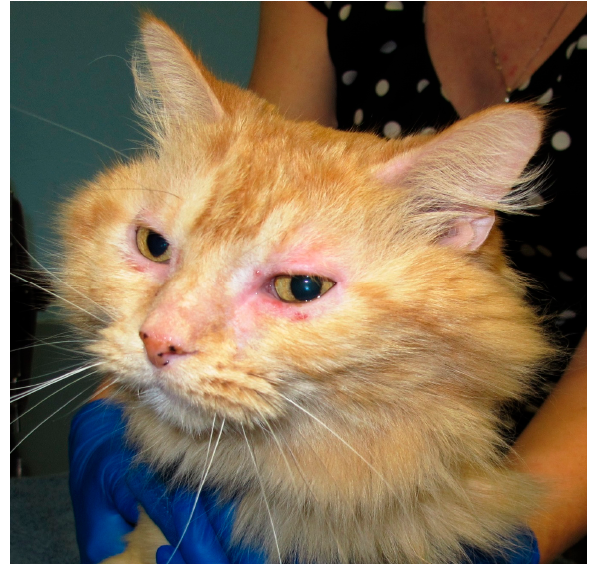
Figure 1. Cat with non-flea, non-food hypersensitivity dermatitis (NDNDHD). Allergic conjunctivitis, sinusitis, and facial pruritus were present.